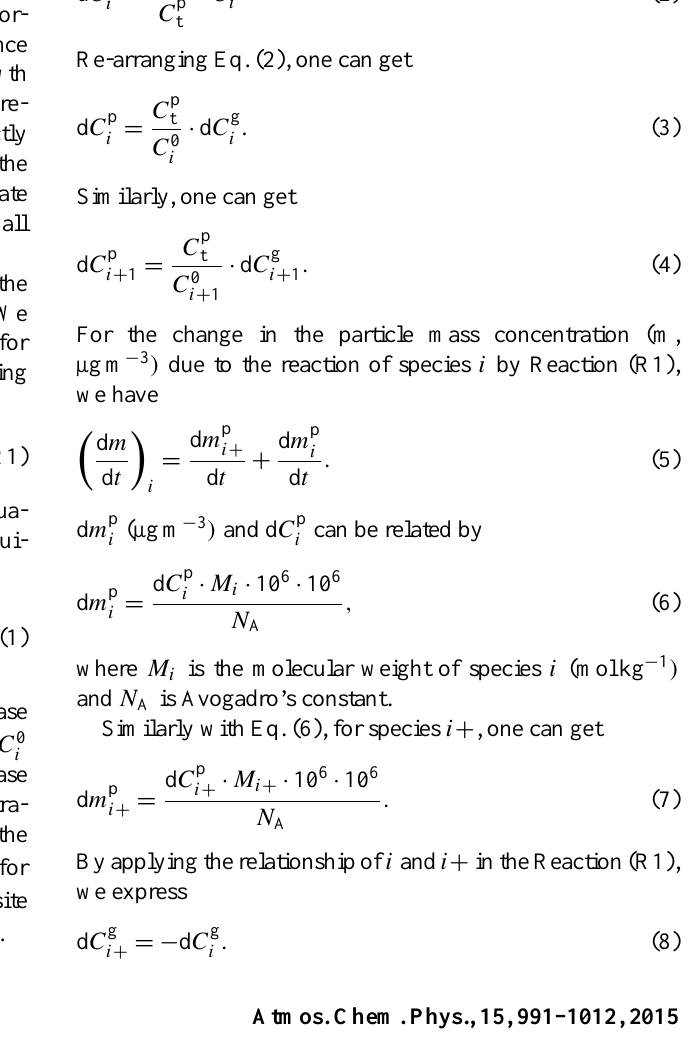
Table 1. Summary of experimental conditions. All experiments were performed at initial RH 75% and NO x <1ppb. Experiment VOC VOC initial [OH] Initial O 3 Average T (K) Initial mass Rate coefficient type type (ppb) (10 6 moleculescm − 3 ) (ppb) (µgm − 3 ) (molecule − 1 cm 3 s − 1 ) b OH oxidation α -pinene 4 β -pinene Ozonolysis α -pinene 4 NDs a 136 β -pinene limonene